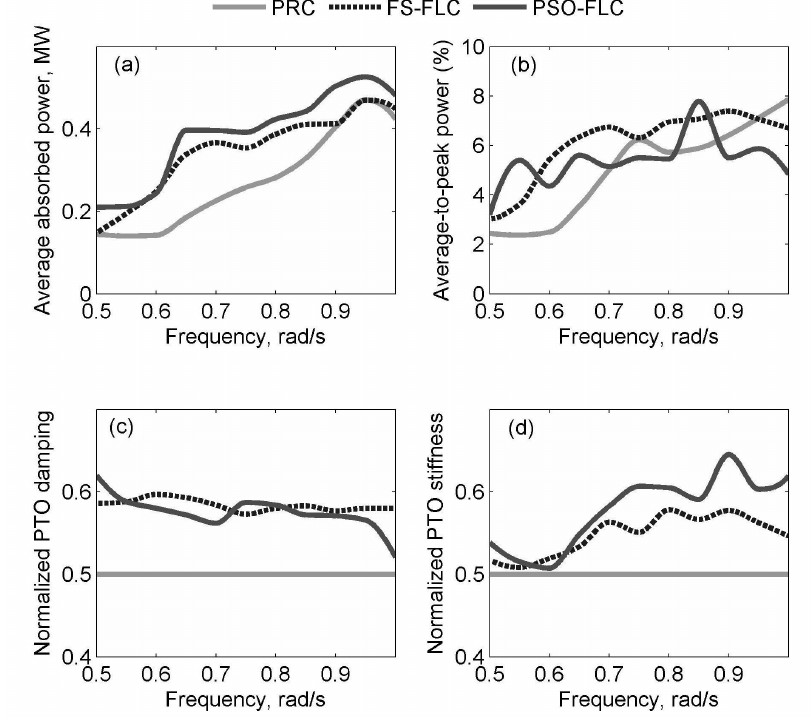
Figure 8. Comparison of the controllers performance for sea-state with H wave frequency ( a ) average absorbed power; ( b ) average-to-peak power ratio; ( c ) normalized PTO damping; ( d ) normalized PTO stiffness.